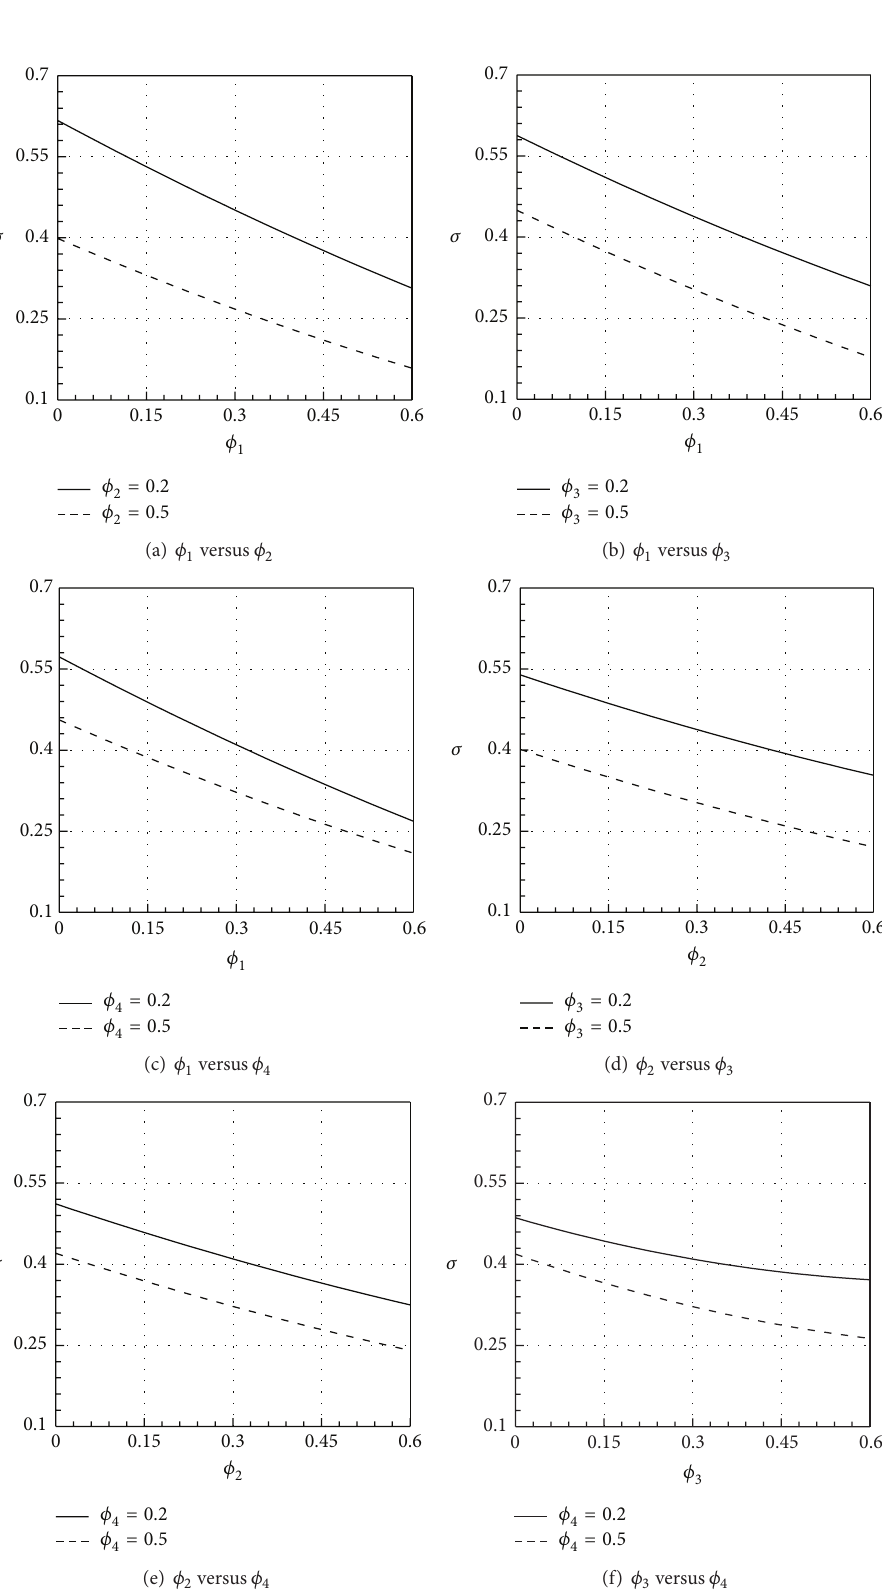
Figure 11: Interaction effects of the design variables on the total pressure recovery